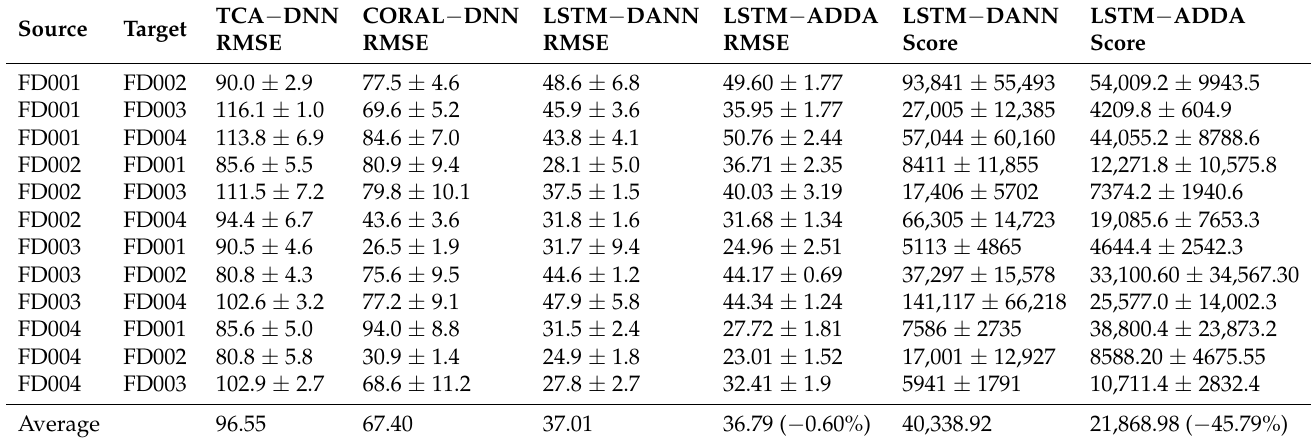
Table 4. Score and RMSE comparsion of unsupervised-domain adaption methods. ( ∆ % denotes the percentage of evaluation metric improvement. ± denotes the standard